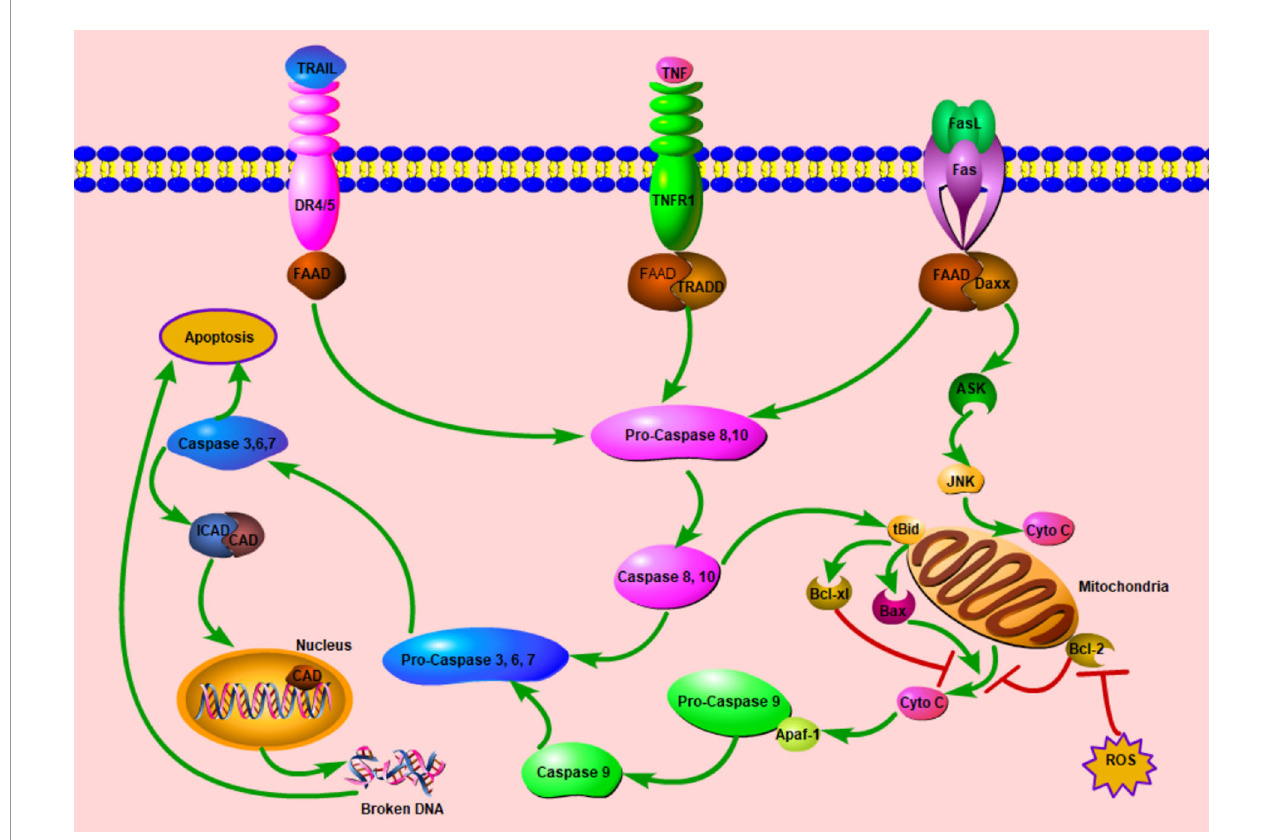
FIGURE 2 | Schematic diagram of cell apoptosis. Once the extracellular cytokines bond to relative death receptors (DRs), DRs recruit FADD intracellularly, this complex initiates the cascade of apoptosis. In some stress conditions, mitochondrial permeability transition will increase, afterwards, Cyto C will be released. With Apaf-1, Cyto C will start the activation cascade from Pro-Caspase 9. In these two ways, caspase 3 is activated fi nally and exerts the apoptosis process with various mechanisms including the DNA fragmentation in the nucleus. The extrinsic pathway can modulate the intrinsic pathway by the tBid, ASK, and JNK. ASK, apoptosis signal-regulating kinase; Apaf-1, apoptotic protease activating factor-1; CAD, caspase-activated deoxyribonuclease; Cyto C; cytochrome C; Daxx, death domain associated protein; DR, death receptor; FAAD, Fas-associated death domain protein; ICAD, inhibitor of caspase-activated deoxyribonuclease; JNK, c-Jun N-terminal kinase; tBid, truncated Bid; ROS, reactive oxygen species; TNF, tumor necrosis factor; TNFR1, tumor necrosis factor receptor 1; TRADD, Tumor necrosis factor receptor type 1-associated death domain protein. TRAIL, tumor necrosis factor related apoptosis inducing ligand; ┤ , Inhibition; ! ,